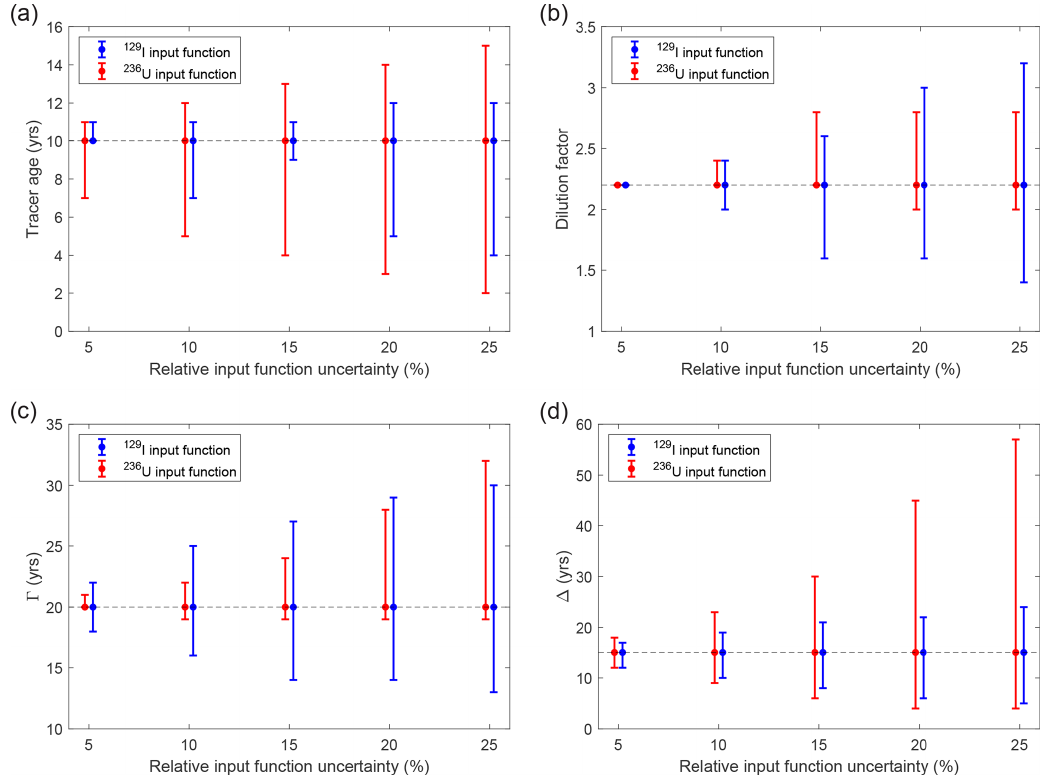
Figure A1. Sensitivity analysis for model parameters as a function of uncertainties in the 129 I (blue) and 236 U (red) surface layer input functions. Shown are tracer ages (a) and dilution factors (b) from the binary mixing model, as well as (cid:48) (c) and (cid:49) (d) from the TTD model. Due to the irregular shape of the input functions, the uncertainties depend on the data itself. Here we used the Amundsen Basin mean value as an example. Input functions were shifted by up to 25%, and the model parameters were